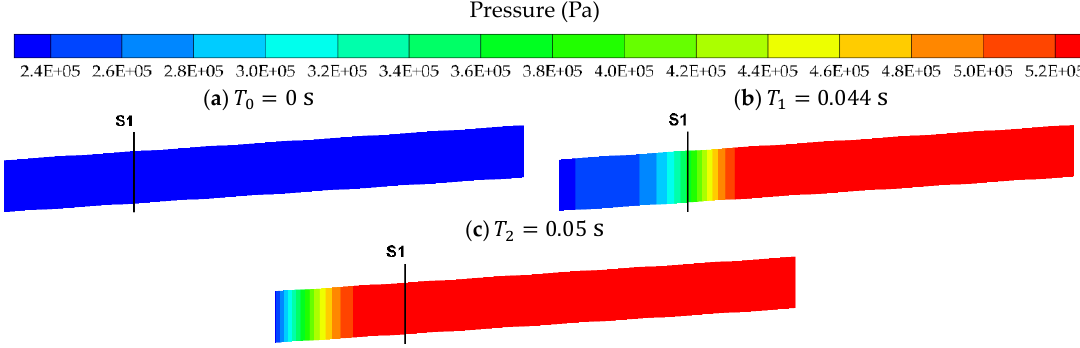
Figure 13. Axial velocity distribution at different time ( 𝑇 3 = 0.058 s and 𝑇 4 = 0.064 s ) of the S1 monitoring point.